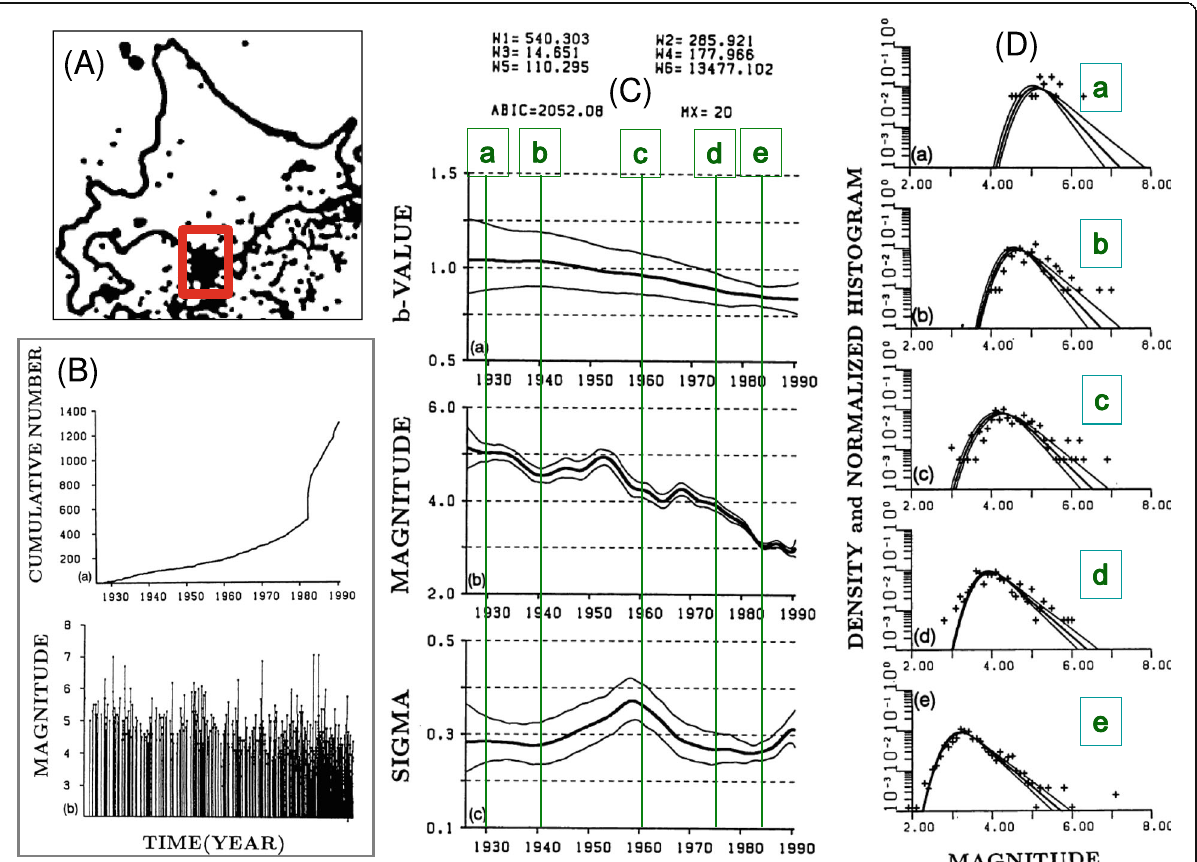
Fig. 10 Temporal detection rate analysis of earthquakes. Detected earthquakes off the coast of southern Urakawa (Urakawa-Oki, ( A )), Hokkaido (1926 – 1990), B cumulative number of earthquakes by year since 1926 with the corresponding magnitude versus occurrence time plot, Ca b values ( b = β log e 10) against time in years, Cb μ values (50% detection rate) against time in years, Cc σ value against time in years, and D magnitude frequency histograms ( “ + ” sign) of in time spans Da 1926 – 1945, Db 1946 – 1965, Dc 1966 – 1975, Dd 1976 – 1983, and De 1984 – 1990 with the estimated frequency-density curves at the middle time (indicated by the squared a – e in panel C ) in the corresponding time spans, where x -axis is for magnitude and y -axis is the frequencies given in logarithmic scale. Theoretically calculated two-fold standard error curves are provided for each